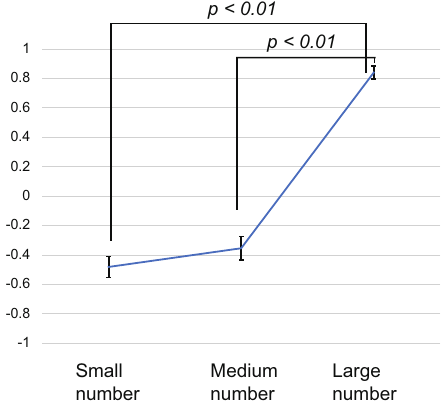
Figure 5. Results of Experiment 1. Scores for each stimulus